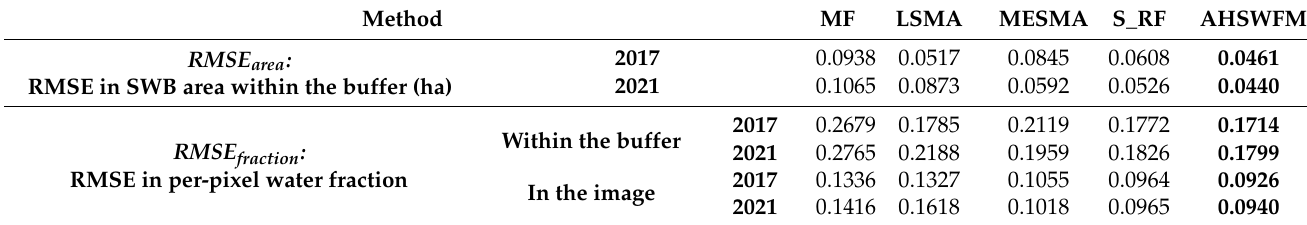
Within the buffer